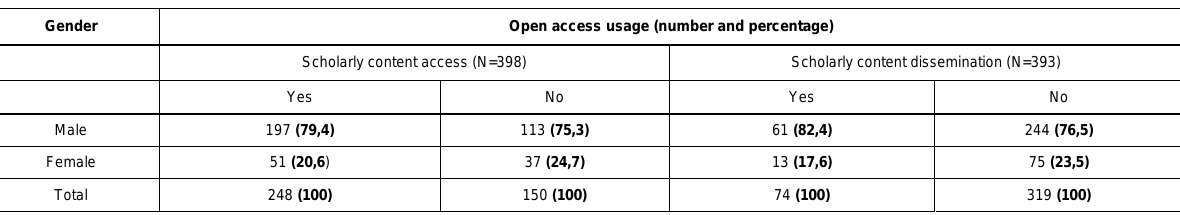
Open access usage by the respondents by